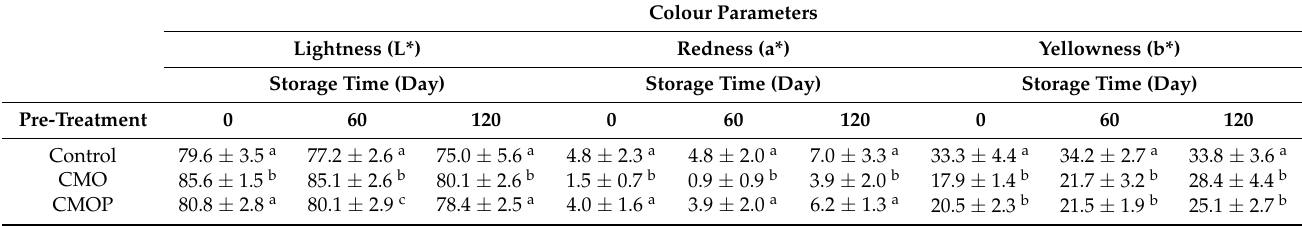
Table 2. Impact of pre-treatment on the colour parameters of the dried apple slices 1 .